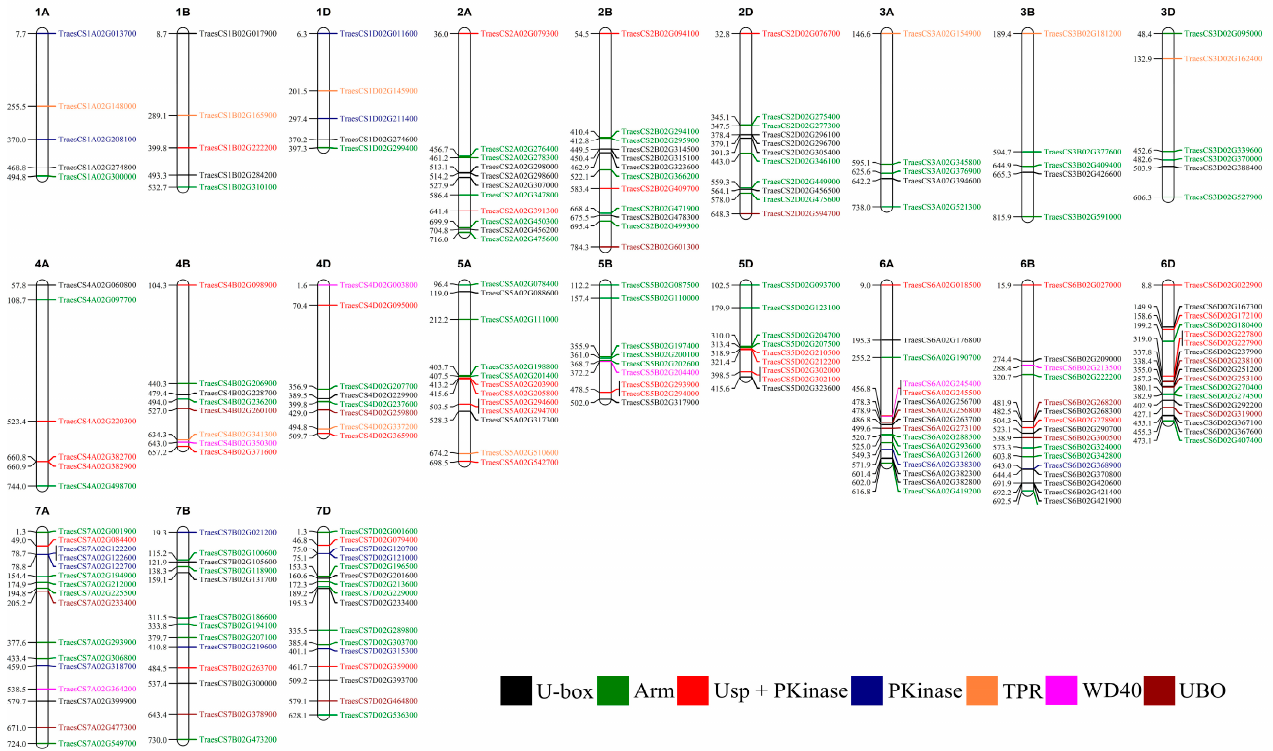
Figure 4. Chromosomal locations of wheat U-box E3 genes. The positions of U-box E3 genes (unit: Mb) are shown on the left of the chromosome, while the numbers on the right indicate the gene identifiers.